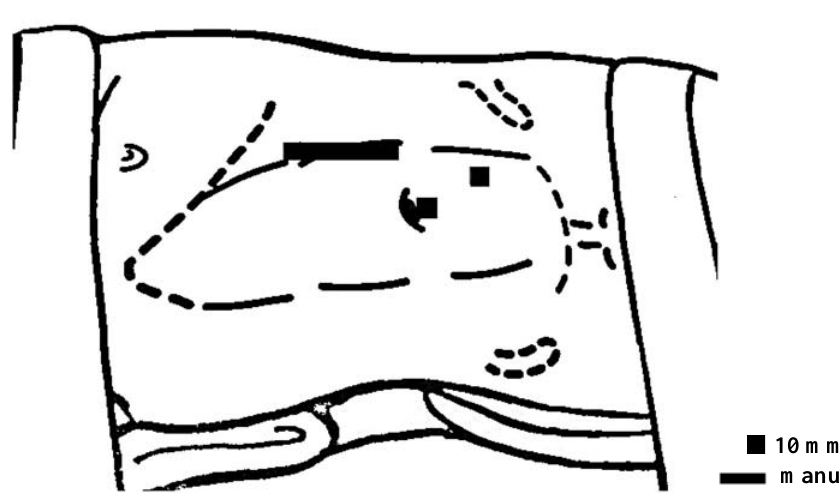
Figure 1 – Unilateral nephrectomy: position of the laparoscopic ports and the manual